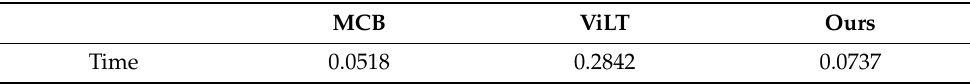
Table 6. Comparison of the running time of MCB, ViLT, and the proposed